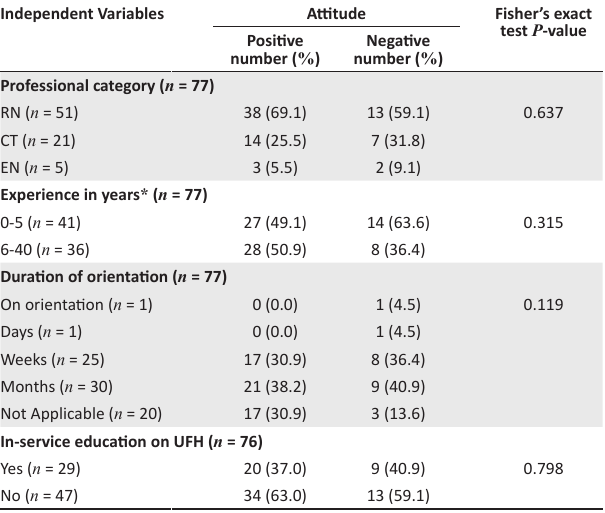
TABLE 5: Association between attitude and selected independent variables.